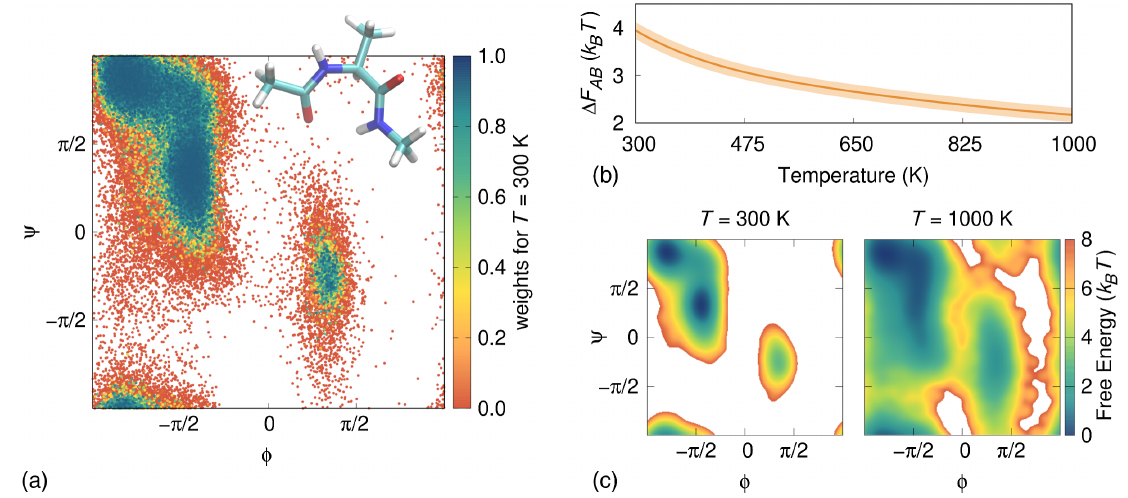
300 K, T 1000 K). (a) Explored configurations as a function min ¼ max ¼ k Þ k − 1 .